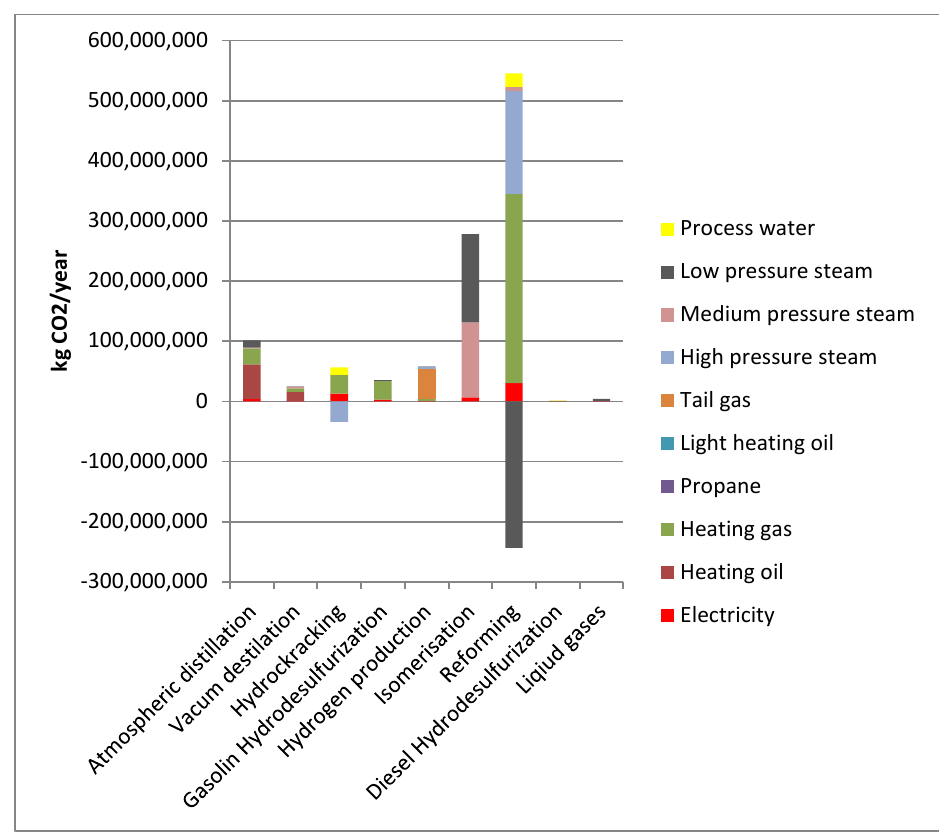
Figure 4. Annual GHG emissions generated by individual installations after allocation to motor gasoline 95.